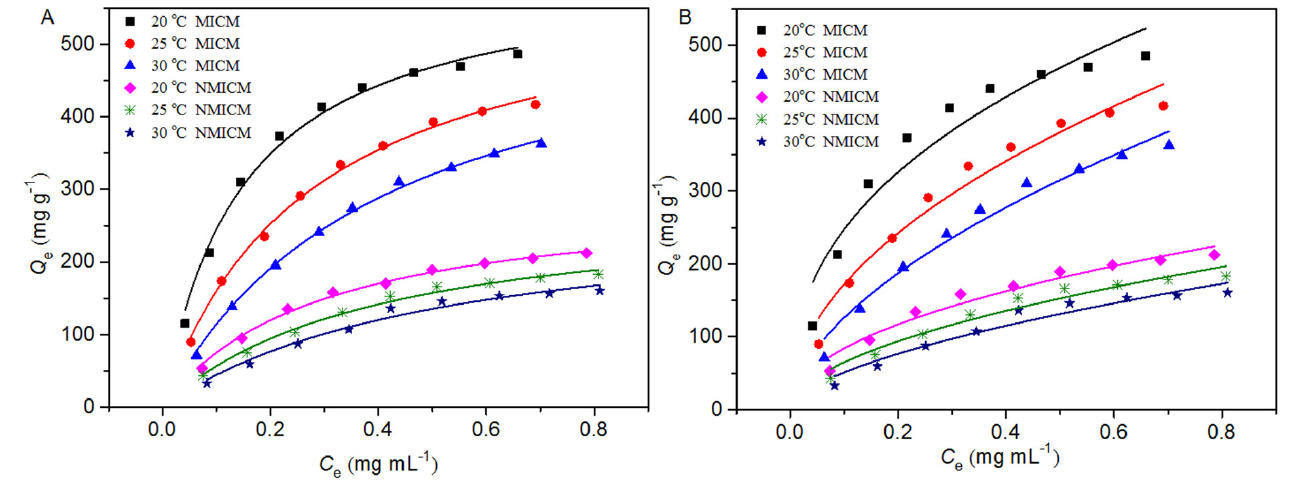
Figure 7. Adsorption isotherm data and the fitting curves by the Langmuir model ( A ) and Freundlich